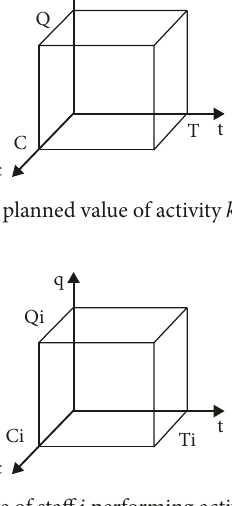
Figure 2: The value of staff 𝑖 performing activity 𝑘 of project j